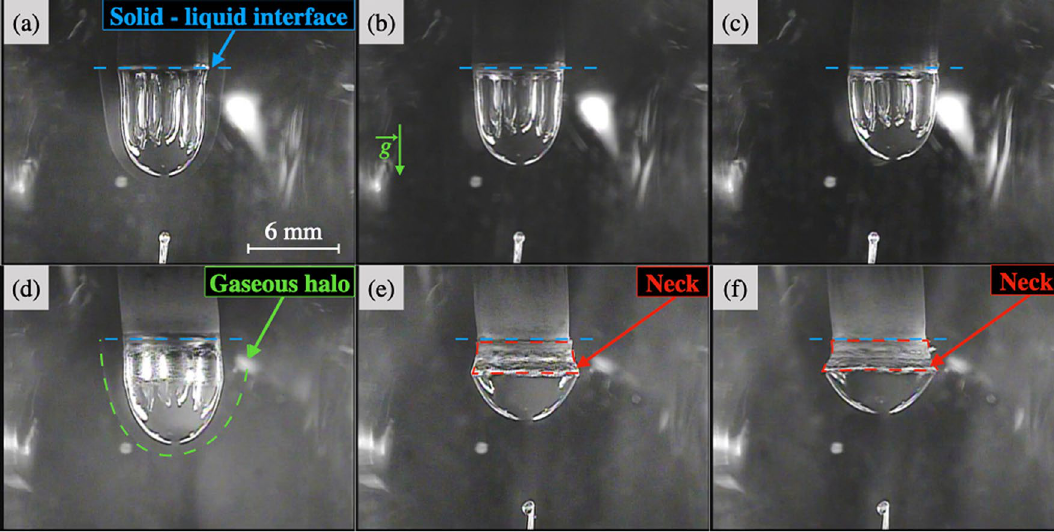
Figure 3. Study of the variation of the shape of the droplets during an experiment at constant temperature. Pictures of (BaS) 0.25 - ( La 2 S 3 ) 0.75 droplet shape ( a ) at the beginning, ( b ) during, ( c ) at the end of the experiment; (BaS) 0.75 - ( La 2 S 3 ) 0.25 droplet shape ( d ) at the beginning, ( e ) during, ( f ) at the end of the experiment. (Camera Watec equipped with a UV